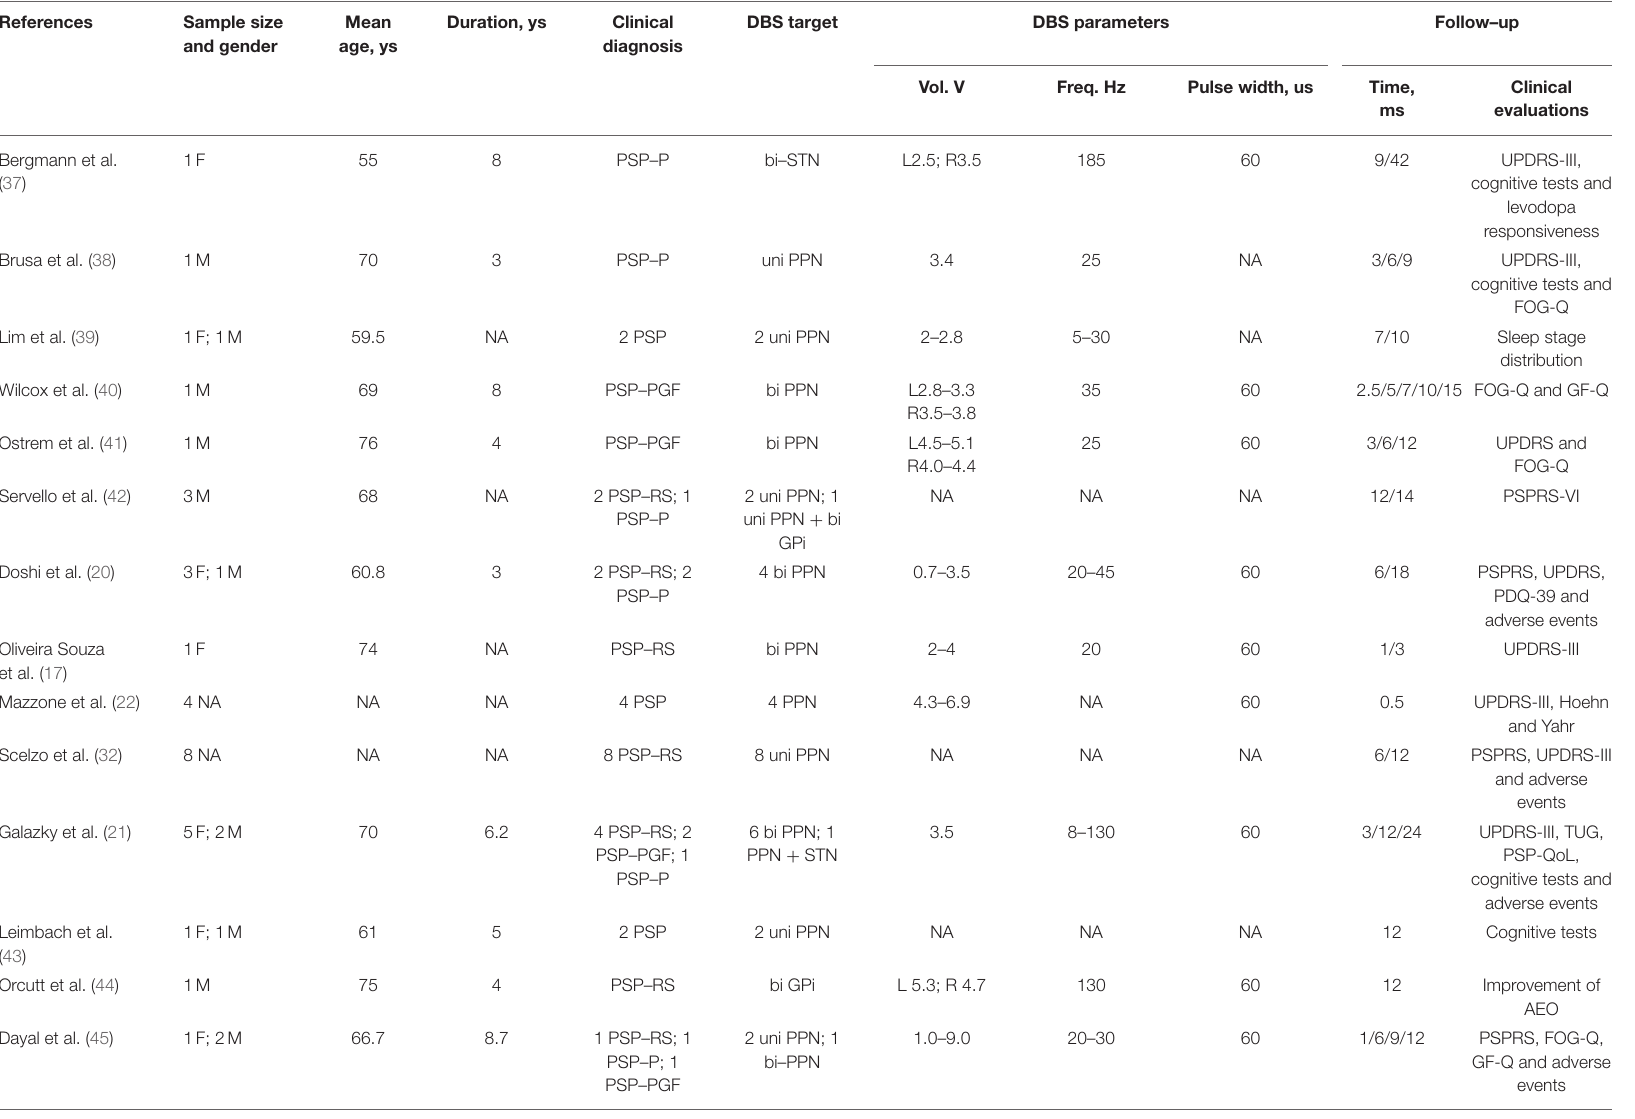
TABLE 1 | Baseline characteristics of the included